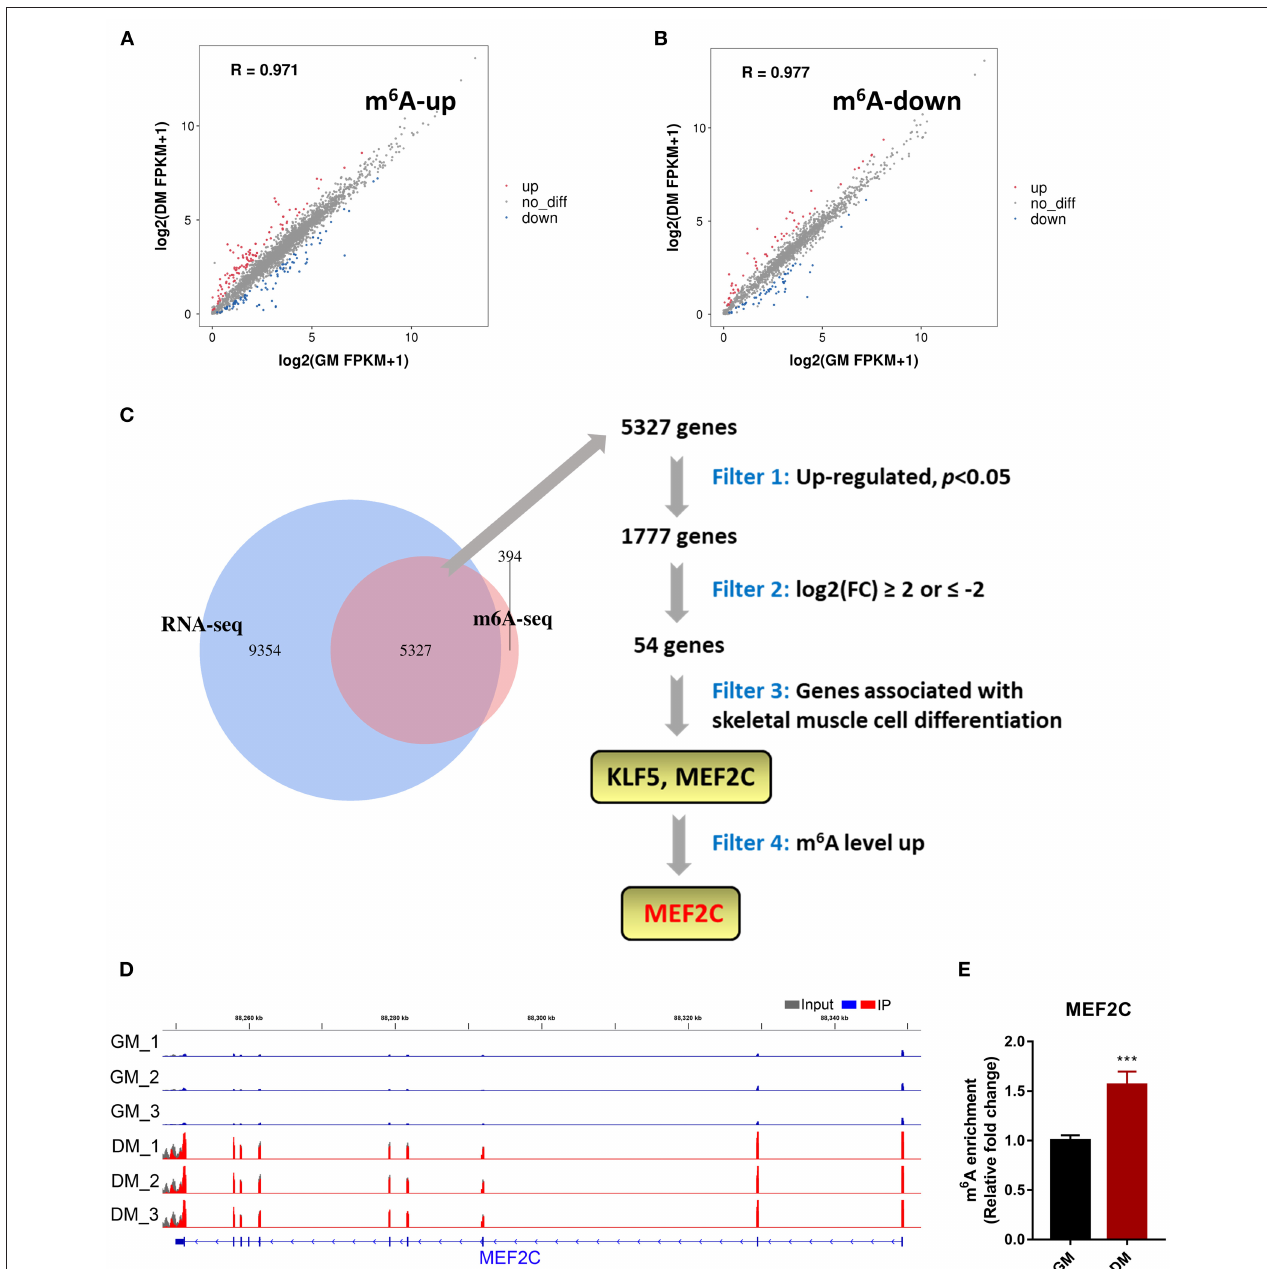
FIGURE 2 | m 6 A methylome profiles of bovine skeletal muscle myoblasts (GM) and myotubes (DM). (A,B) Distribution of genes with significant differences in the both m 6 A level and gene expression level between the GM and DM. (C) Venn diagram showed the overlapping genes identified by MeRIP-seq and RNA-seq, and bioinformatic analysis identified MEF2C as a target gene of m 6 A modification during bovine skeletal myoblast differentiation. (D) IGV tracks displayed the distribution of m 6 A peaks in the MEF2C transcript in all 6 groups. (E) Validations of the m 6 A enrichment of MEF2C mRNA by MeRIP-qPCR. Data were presented as means ± SD. *** p < 0.001; Student’s t